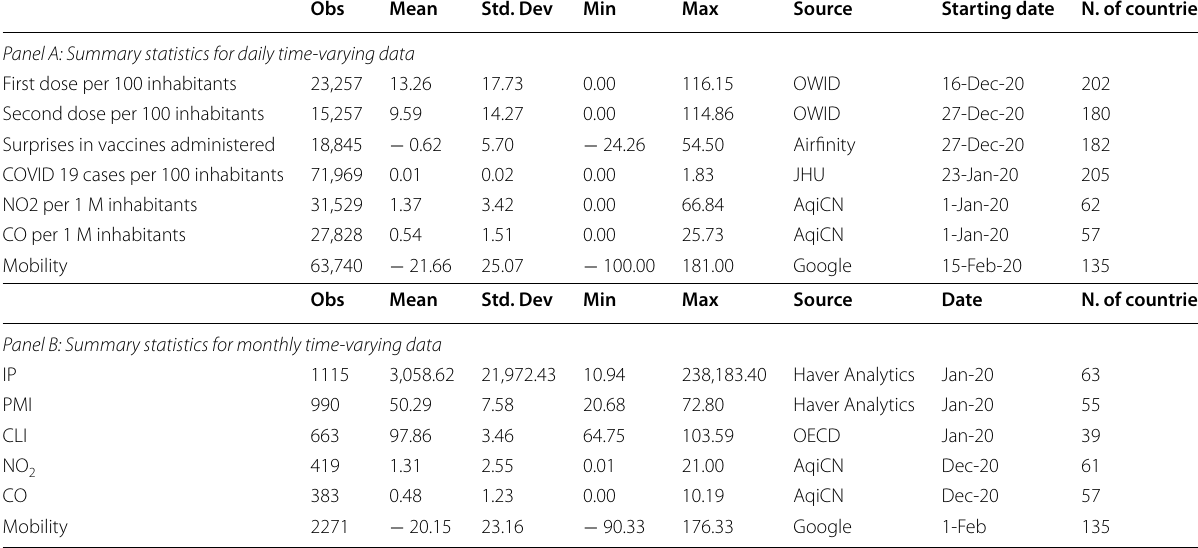
Table 7 Summary statistics